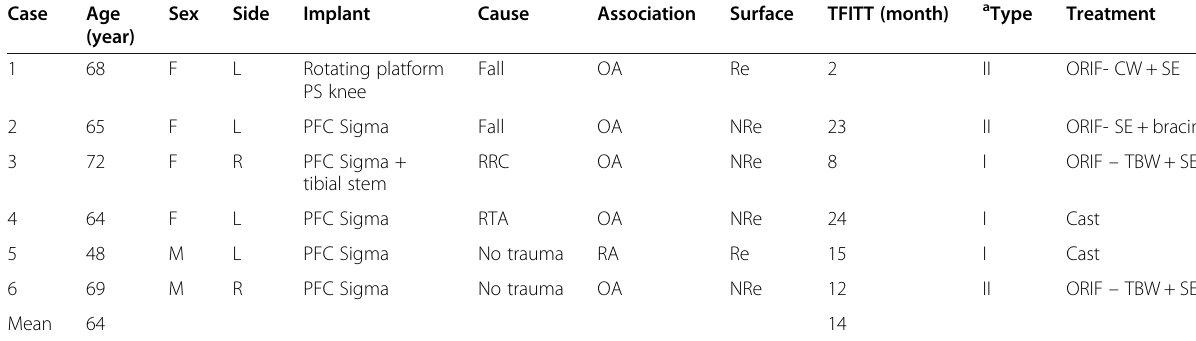
Table 1 Details of 6 patients with peri-prosthetic patella fractures Case